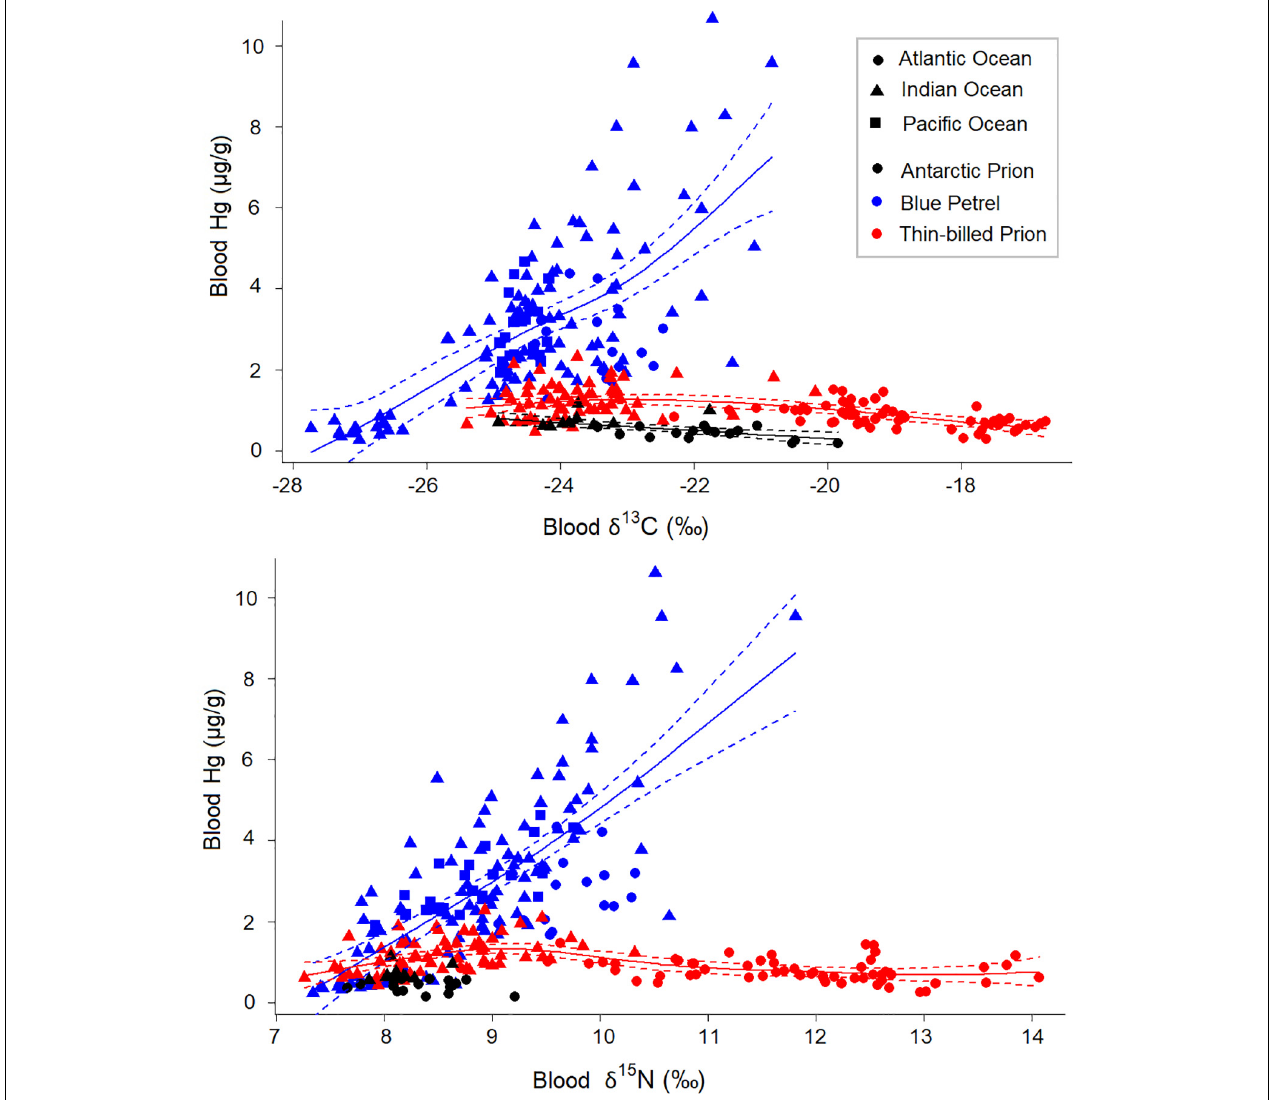
FIGURE 8 | Species-specific Generalized Additive Model (GAM) model fits for mercury values in blood of Antarctic Prions, Blue Petrels, and Thin-billed Prions. Estimated smoothing curves for mercury values in blood in relation to δ 13 C and δ 15 N are given with 95% confidence intervals where statistically significant. For GAM statistics, see Table 5